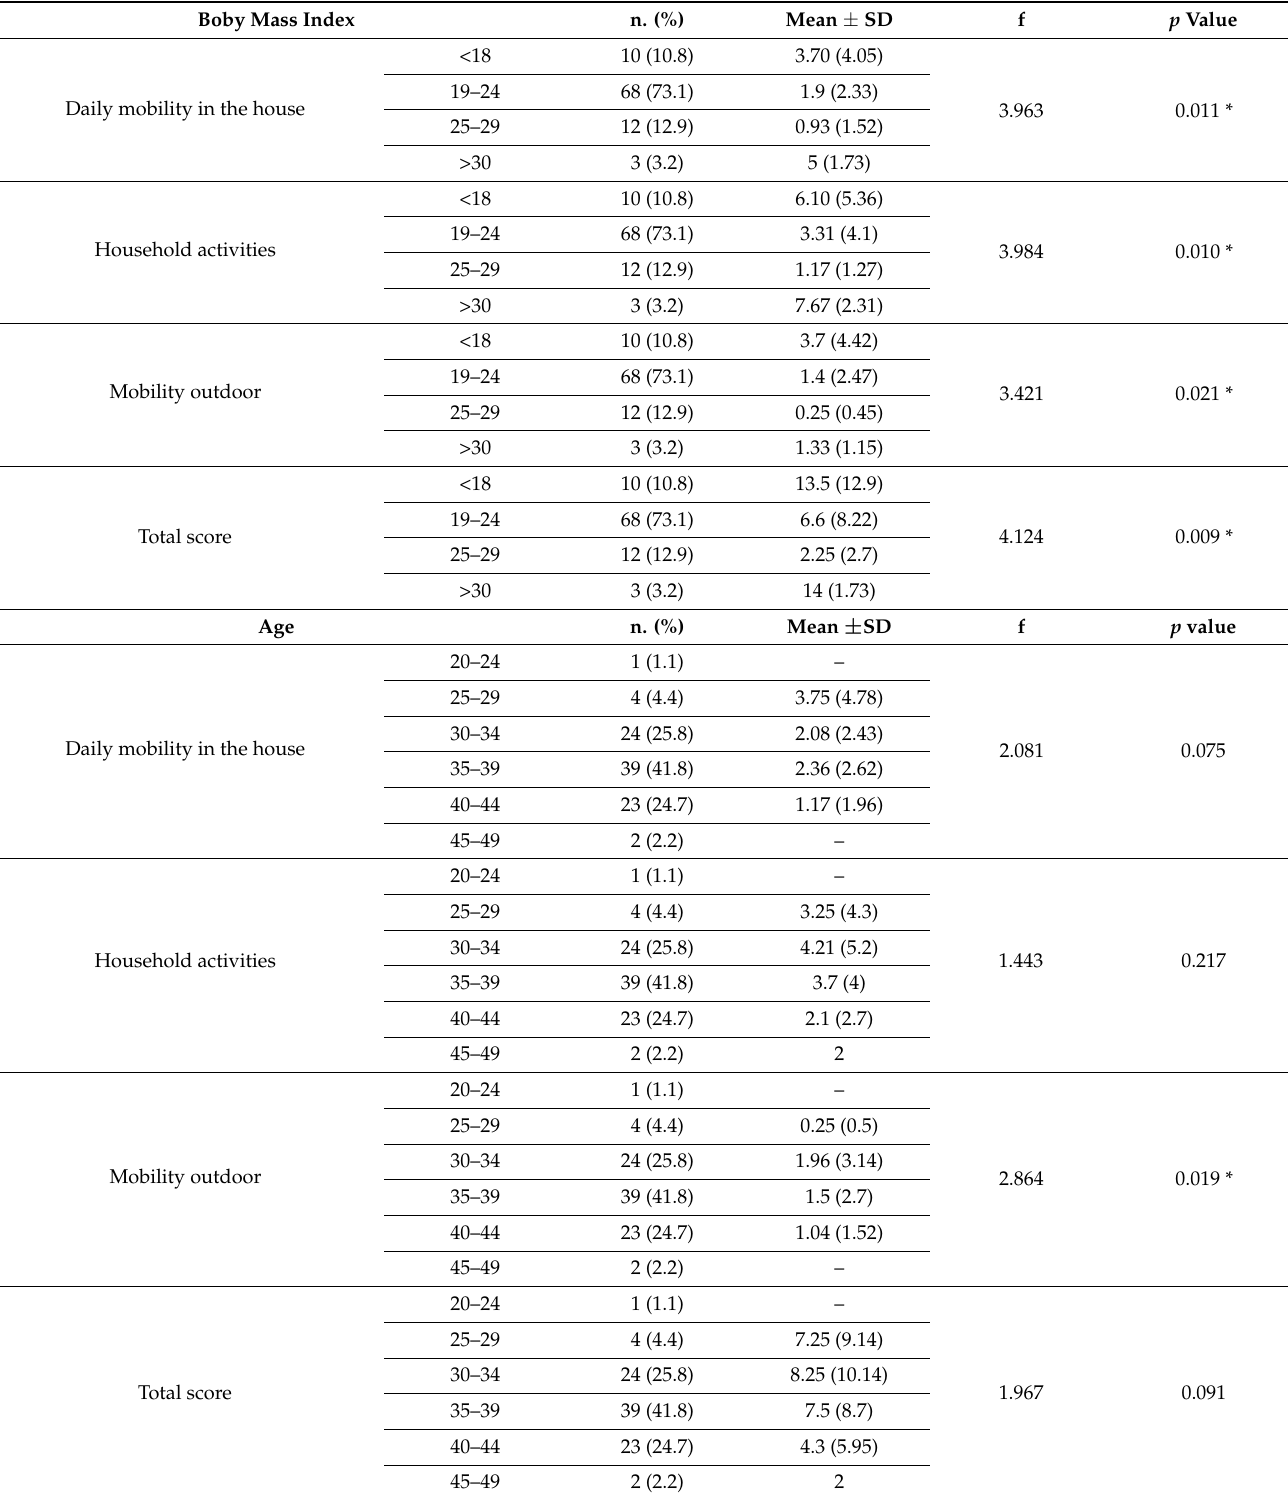
Table 4. ANOVA results considering the PMI subscales and total score, and age and BMI of the sample * p <